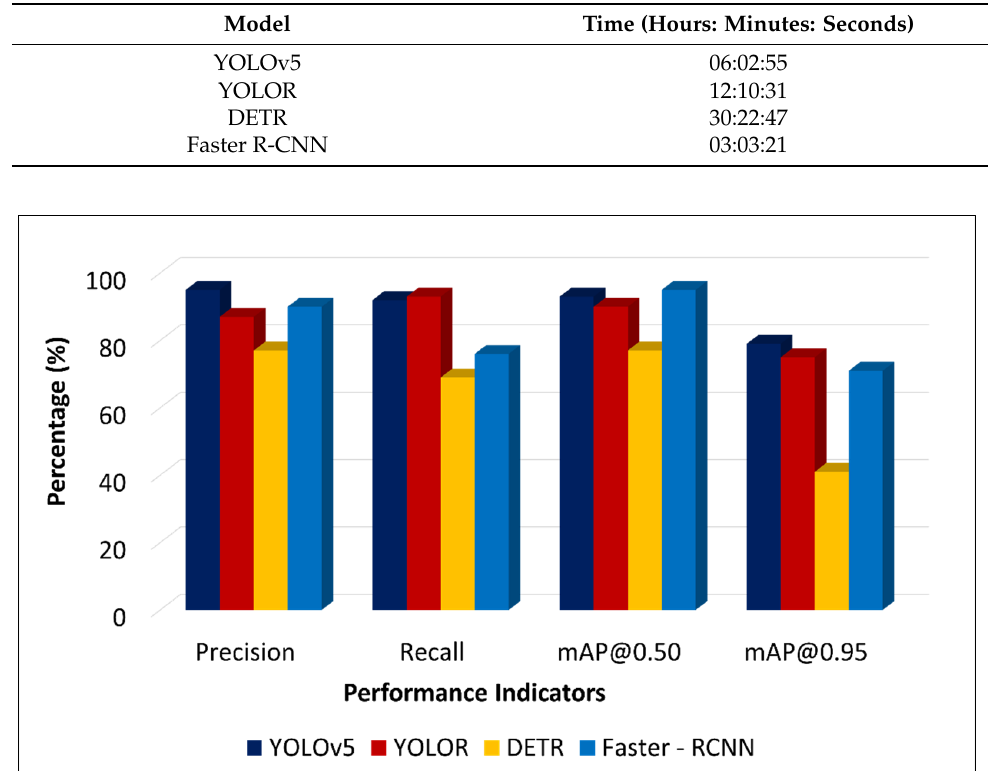
Figure 13. Comparison of performance for different DL models.